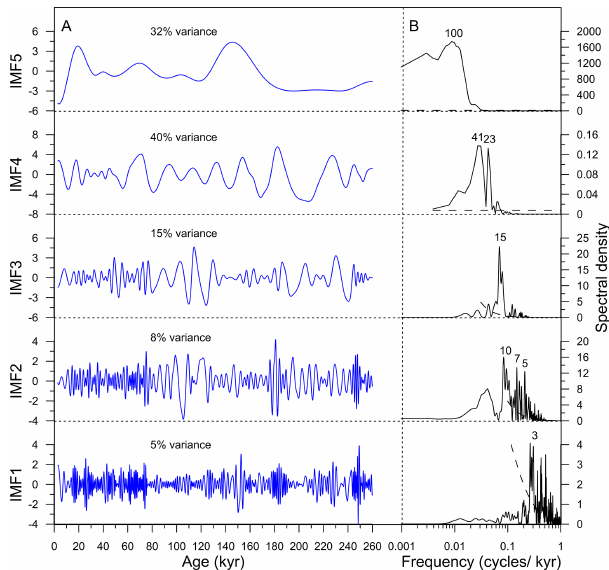
Figure 4. IMFs of Gulang MGS series (a) and corresponding spec- tra (b) . Numbers in black are dominant periods and dotted lines represent the 90% confidence